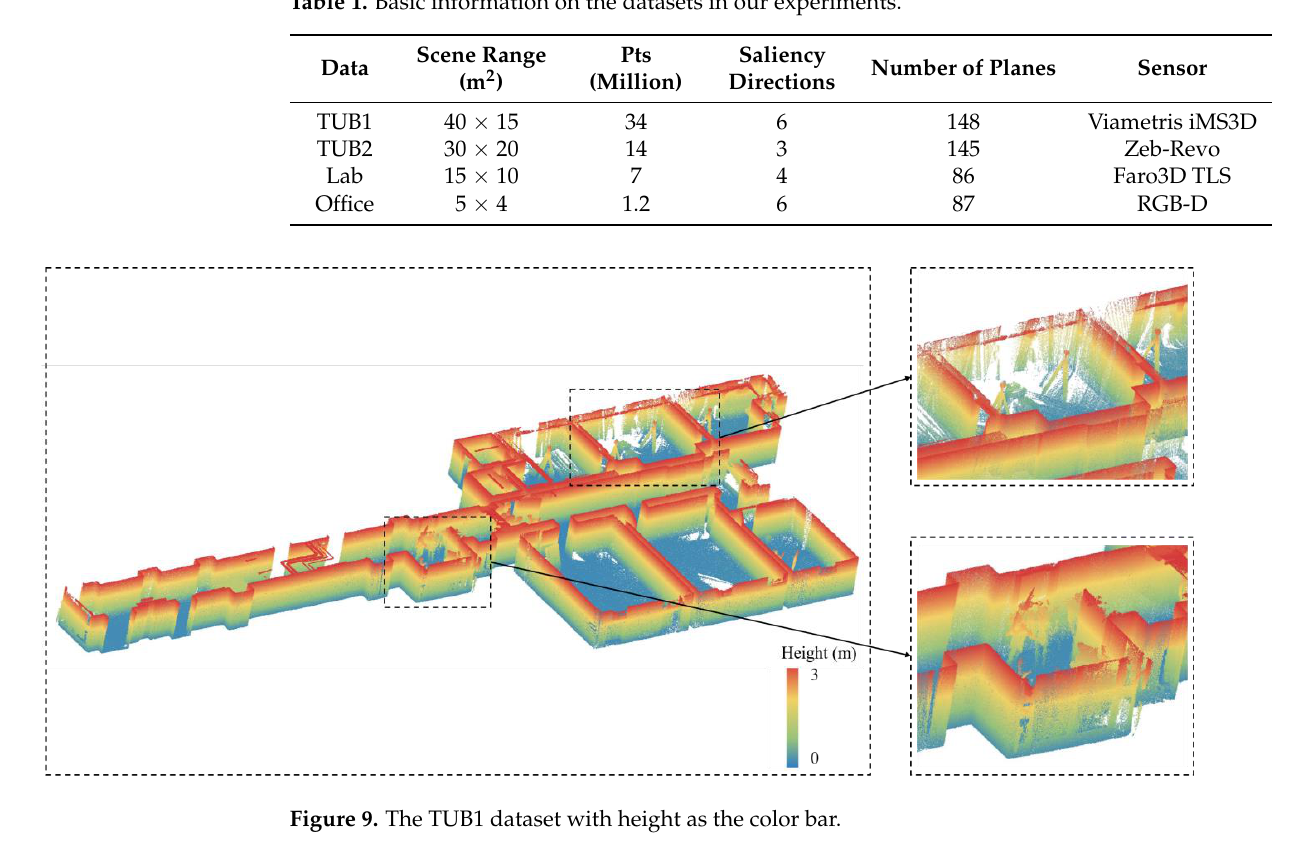
Figure 9. The TUB1 dataset with height as the color bar.